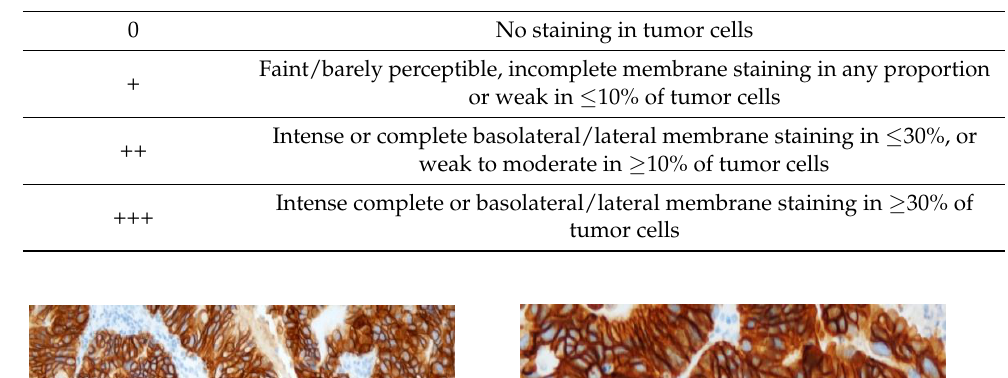
Table 1. HER2 protein immunohistochemistry classification criteria.